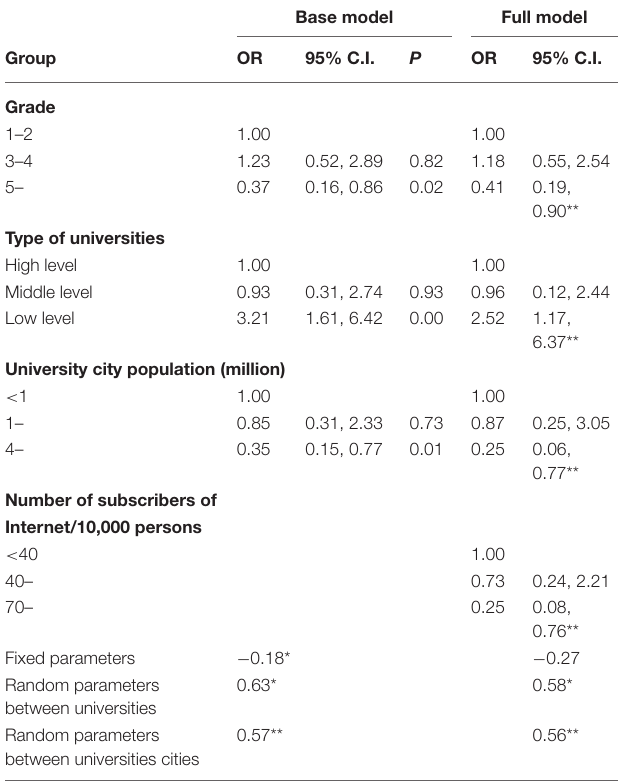
TABLE 2 | Results of multiple level